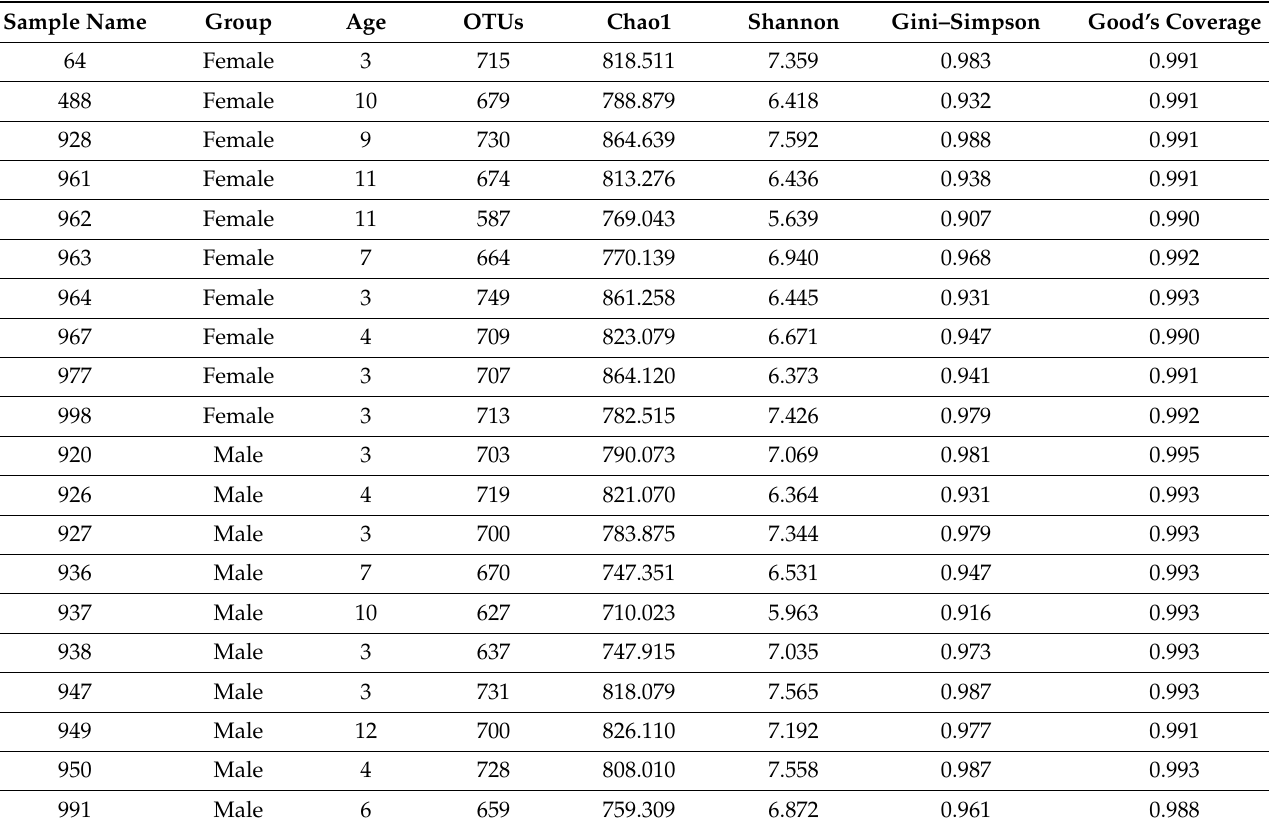
Table 1. Number of samples analyzed, estimated OTU richness (Chao1), Shannon index, GiniSimpson index and estimated sample coverage for 16S rRNA libraries. Sample level composition of